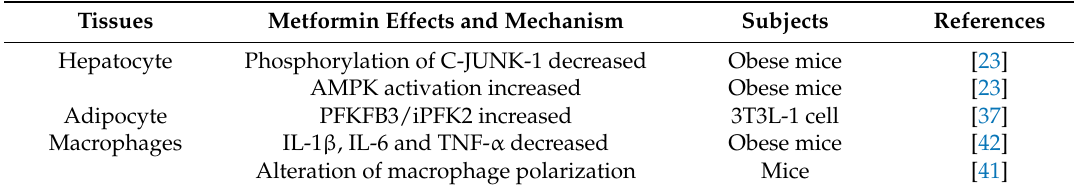
Table 3. Metformin reduces